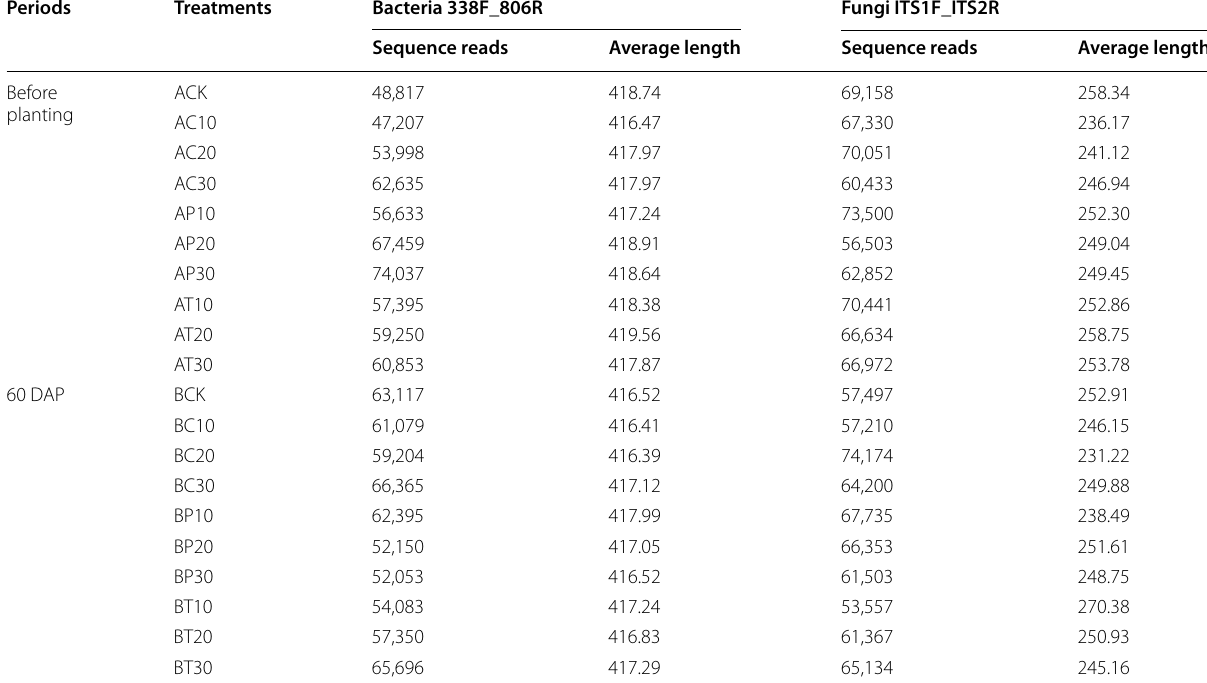
Table 3 Sample data statistics of vegetable residues application and continuous cropping soils Periods Treatments Bacteria 338F_806R Fungi ITS1F_ITS2R Sequence reads Average length Sequence reads Average length Before planting